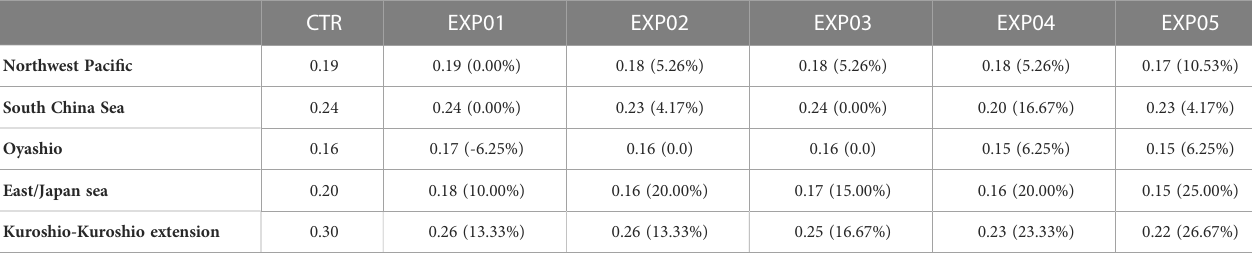
The number in the parentheses below RMSE represents